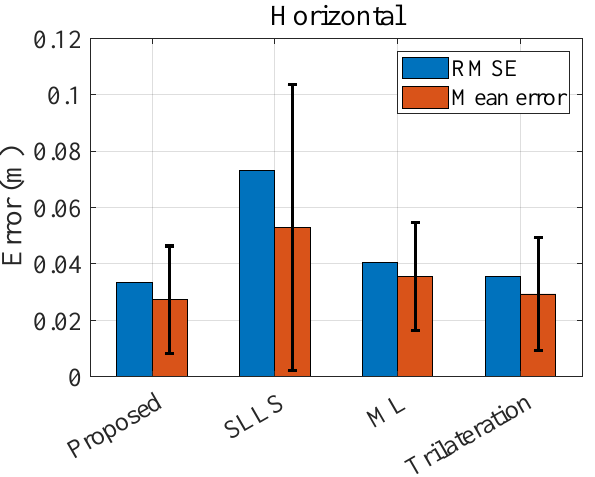
Figure 5. The overall horizontal positioning result; error bars donate